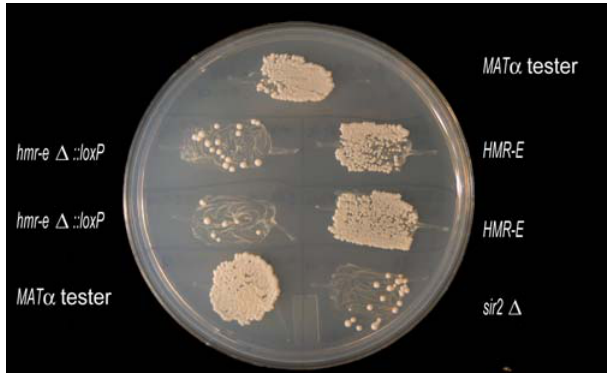
Figure 4. Deletion of the S.bayanusHMR-E resulted in loss of silencing. Mating test of MAT a strains to MAT a tester strain (JRY2726). Disruption of silencing changed the mating type of the MAT a strains to nonmating phenotype of a / a diploid. Two independently constructed S. bayanus hmr-e deletion strains (JRY8785, JRY8786) lost silencing to the same extent as the S. bayanus sir2 D strain. The parental HMR-E strains (JRY8781, JRY8782) mated as efficiently as the S. cerevisiae control (JRY2728).